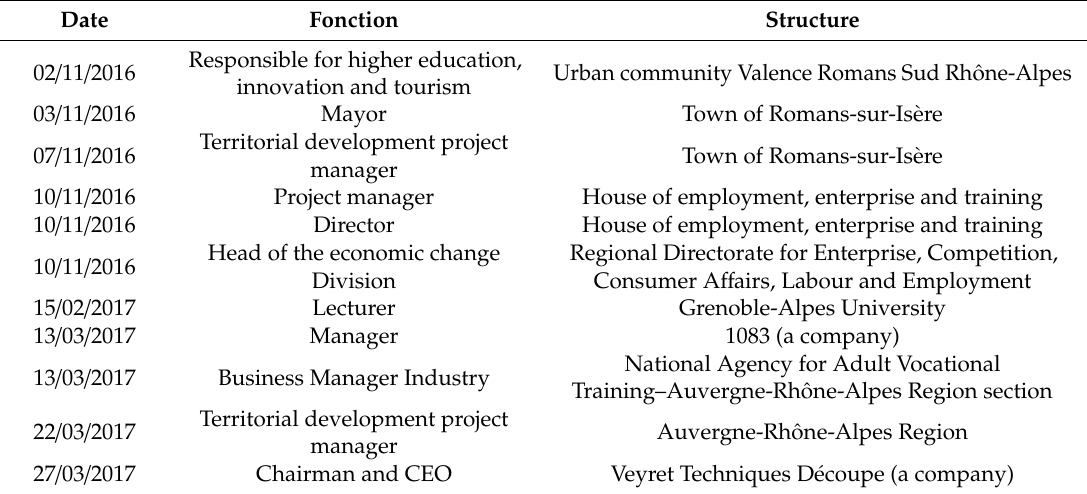
Table 1. Summary of